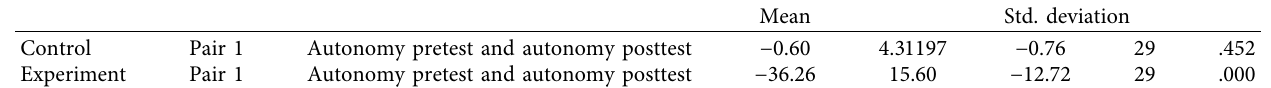
Table 10: Paired-sample test:paired differences.